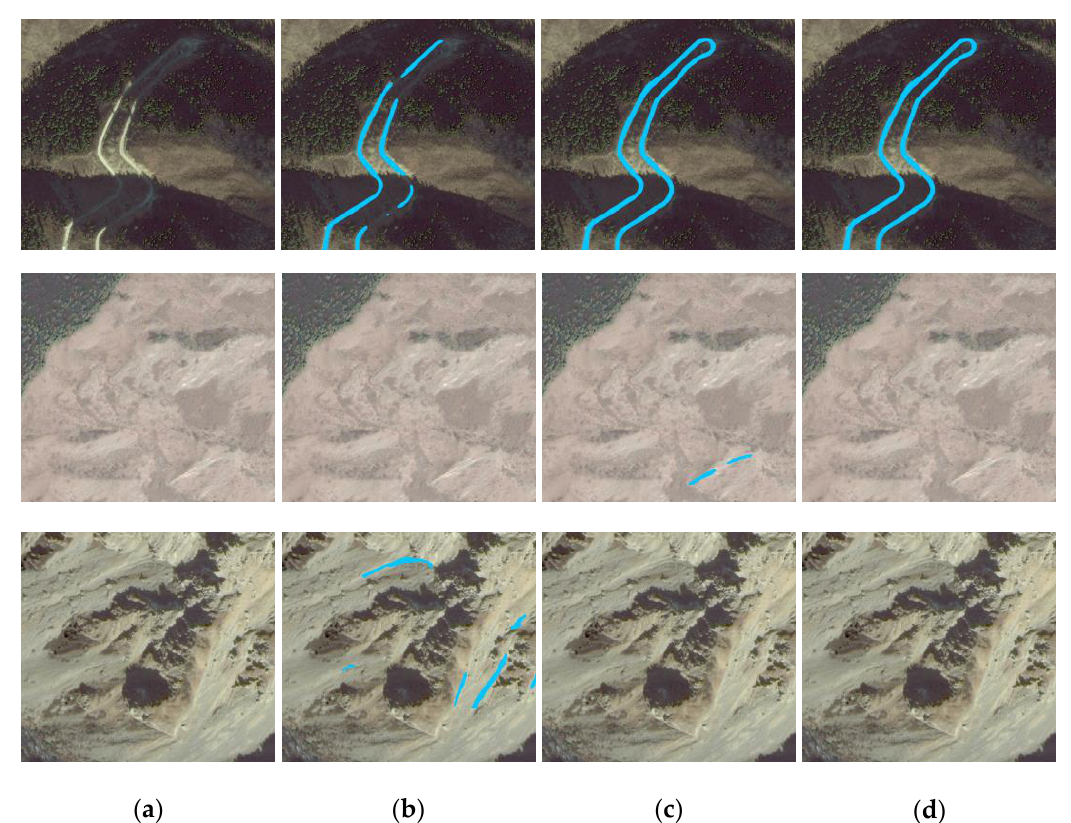
Table 3. Accuracy of different experimental models.